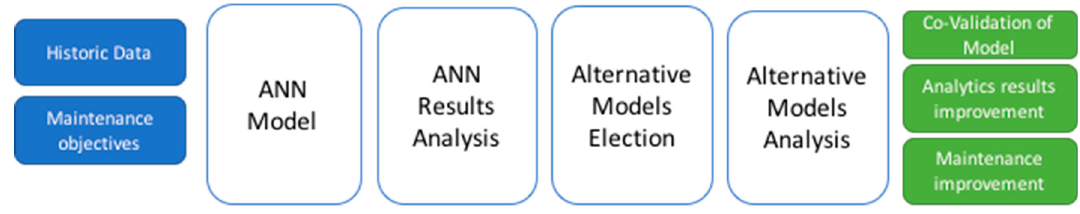
Figure 4. Methodology for using alternative DM techniques.